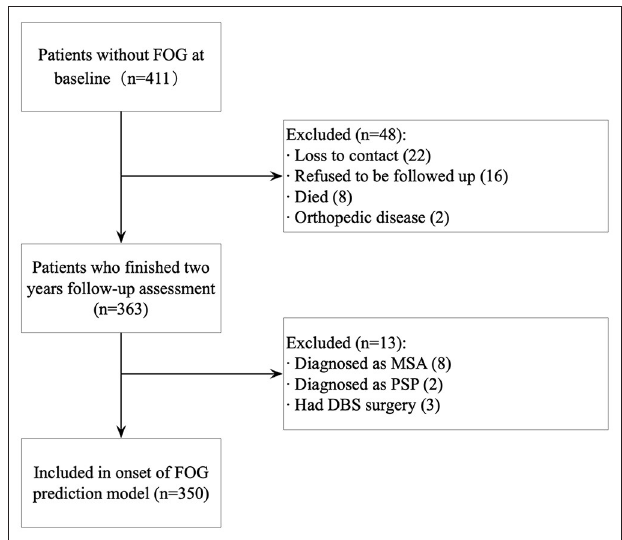
FIGURE 1 | Participant selection for model development. FOG, freezing of gait; MSA, multiple system atrophy; PSP, progressive supranuclear palsy; DBS, deep brain stimulation.